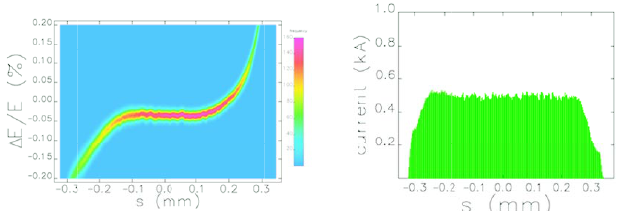
FIG. 9. (Color) The electron density distribution in the longitu- dinal phase space (left plot) and a histogram of the peak current (right plot) at the entrance of the FEL undulators calculated for the FERMI@Elettra